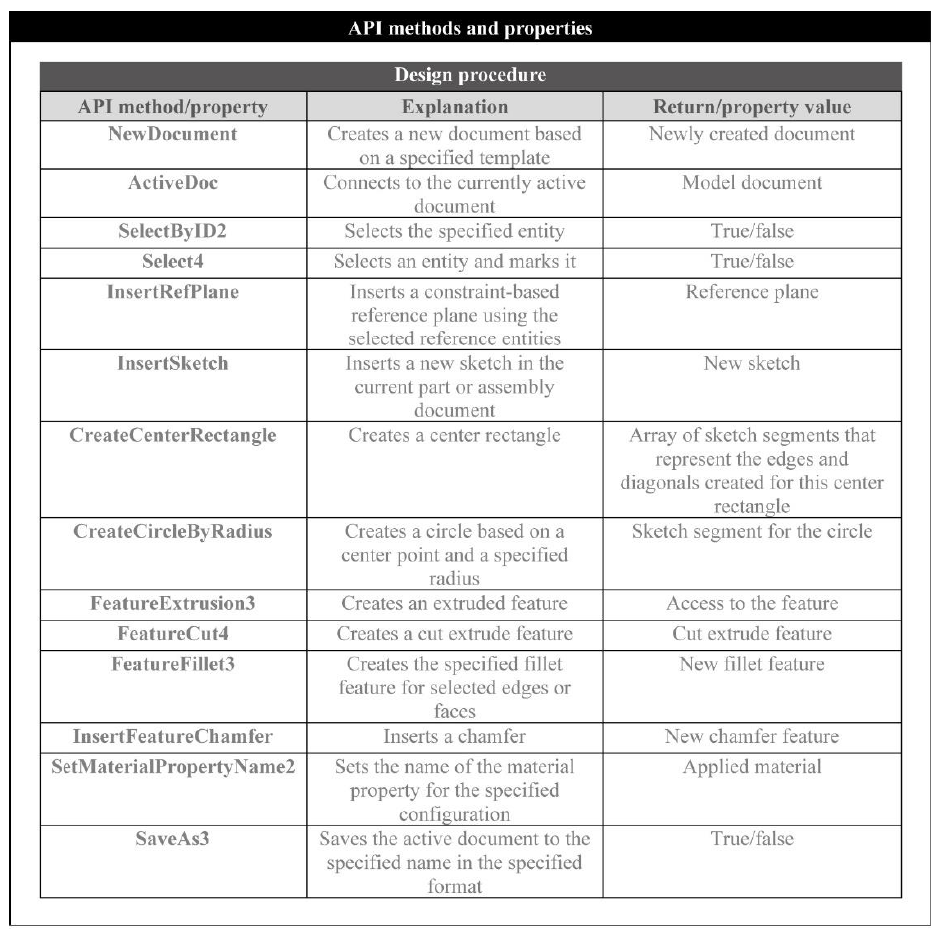
Figure 4. API methods and properties used for the design procedure.